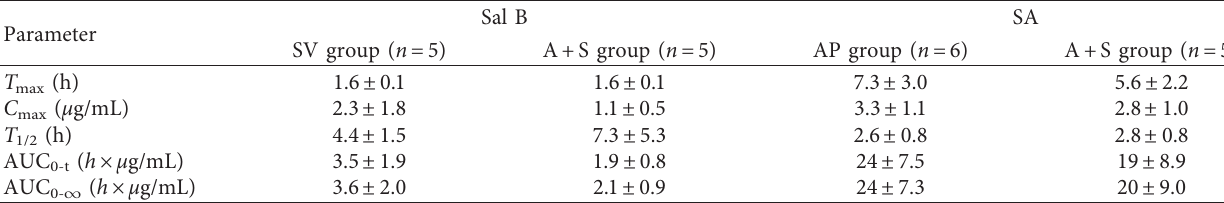
Table 7: Mean of pharmacokinetic parameters of Sal B in the SV group and A+S group and SA in AP group and A+S group (mean ± SD%).